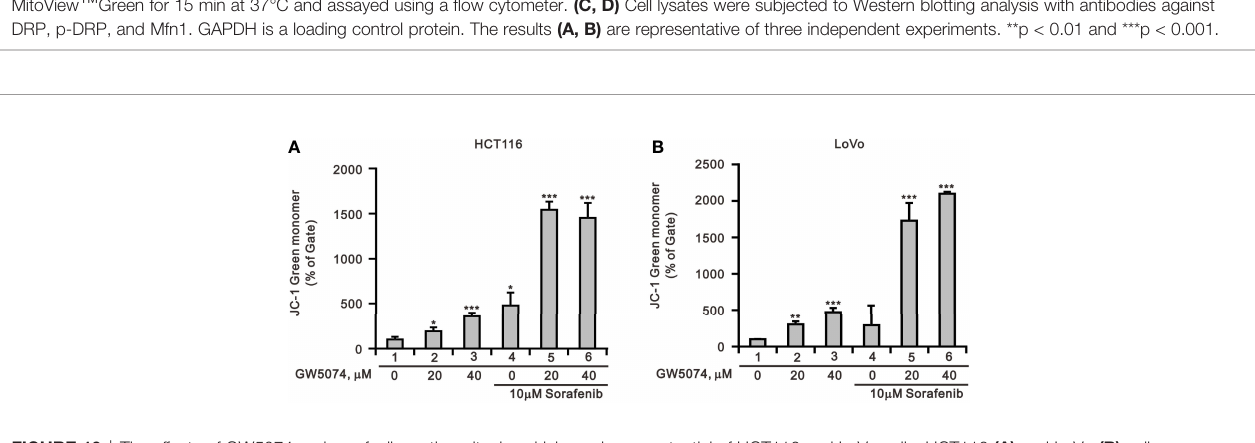
FIGURE 10 | The effects of GW5074 and sorafenib on the mitochondrial membrane potential of HCT116 and LoVo cells. HCT116 (A) and LoVo (B) cells were treated with 0, 20, and 40 µM GW5074 in the absence or presence of 10 µM sorafenib for 24 h and assayed with JC-1 dye using a fl ow cytometer. The results are representative of three independent experiments. * p < 0.05, ** p < 0.01, and *** p <